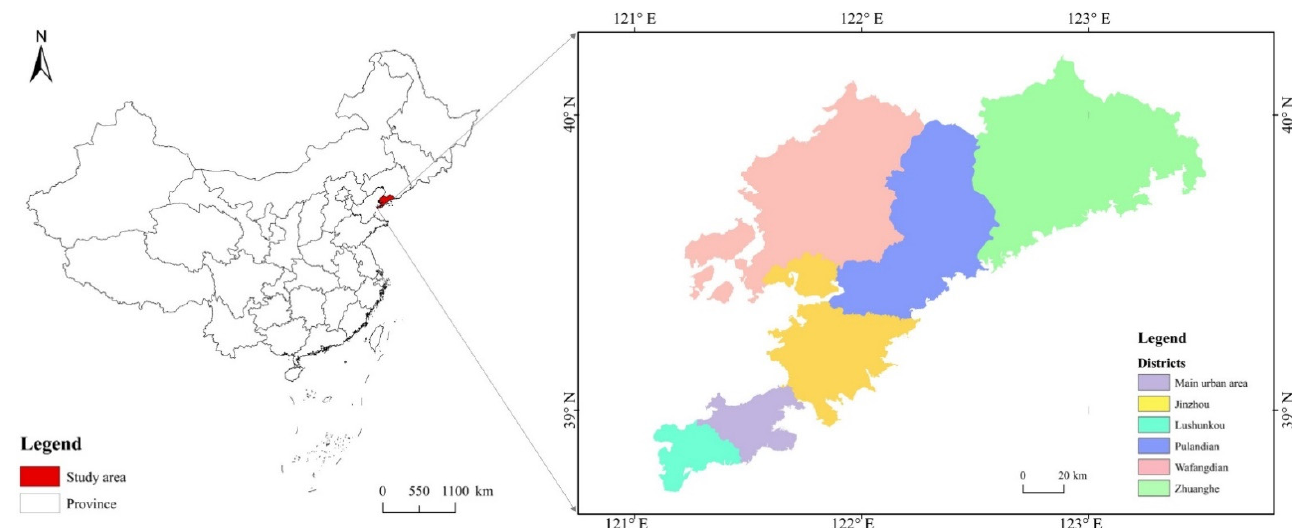
Figure 1. Location and administrative divisions of Dalian.